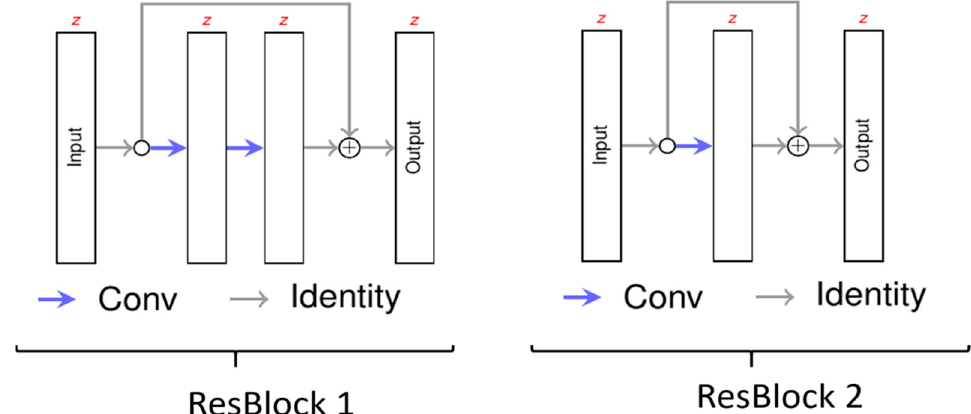
Figure 2. The architecture of residual blocks. Each layer has the same number of features. Each blue arrow (Conv) consists of a convolutional layer and a rectified linear activation.